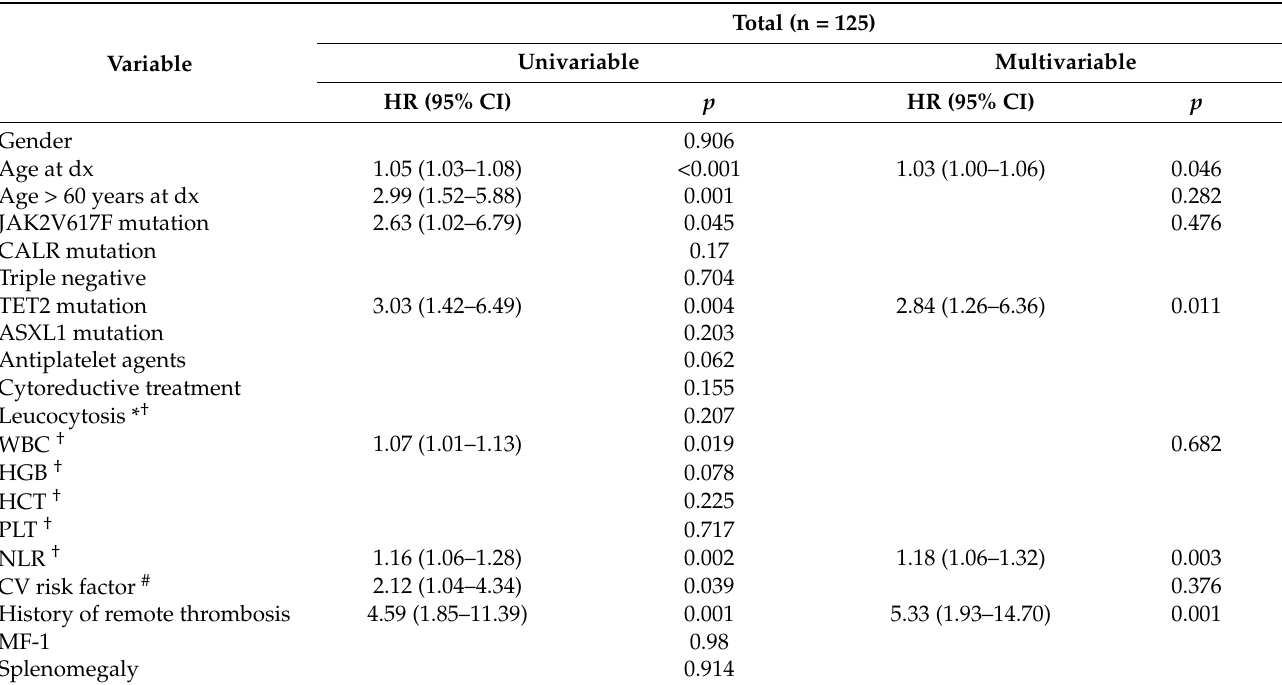
Table 2. Univariate and multivariate analysis of risk factors for thrombosis in MPN